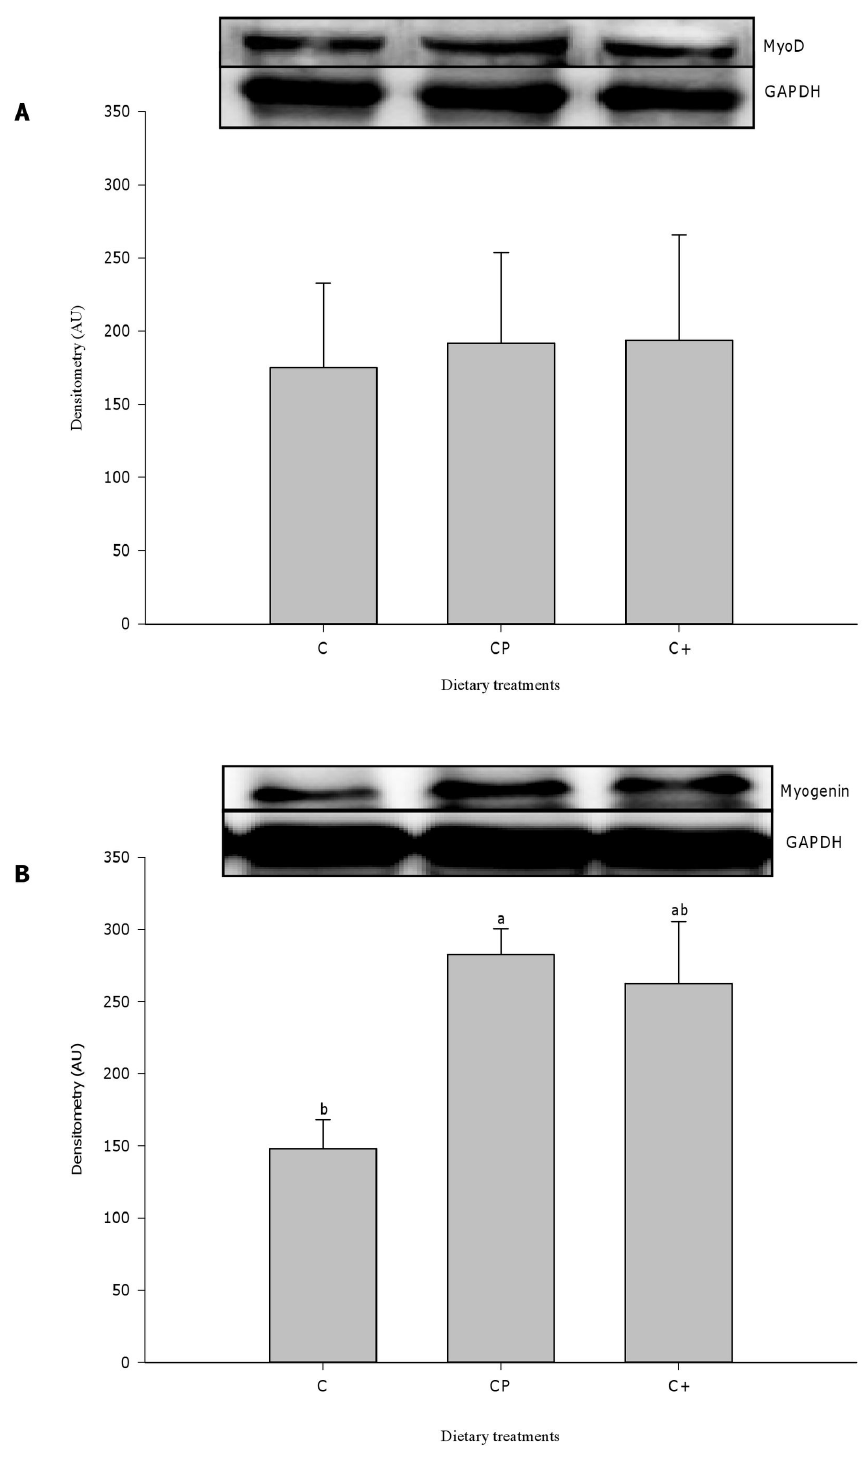
Figure 6. Expression level of MyoD and myogenin, performed by immunoblotting. The expression of MyoD (A) and myogenin (B), both are usually up-regulated during muscle regeneration, was measured in the injured muscles at day 2 and day 5, respectively. All values were corrected for GAPDH as a protein loading control. Results are expressed as a percentage of values obtained at day 0 (mean ± SEM, n = 3/group). Groups bearing different letters for a given time point are significantly different (p≤0.05). C, casein; CP, cod protein; C + , casein supplemented with L-arginine, glycine, L-taurine and L-lysine. doi: 10.1371/journal.pone.0077274.g006 PLOS ONE |